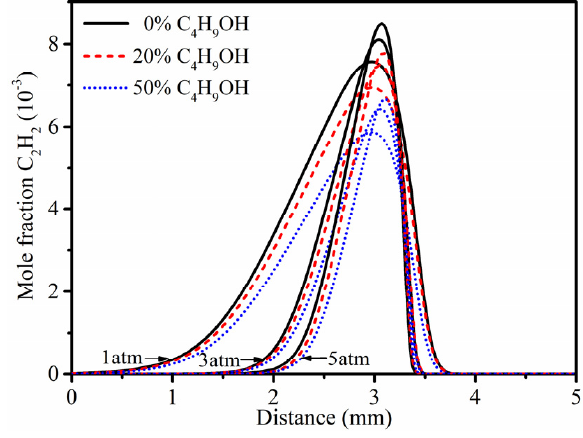
Figure 8. Mole fractions of C 2 H 2 with different levels of n -butanol at different pressures.